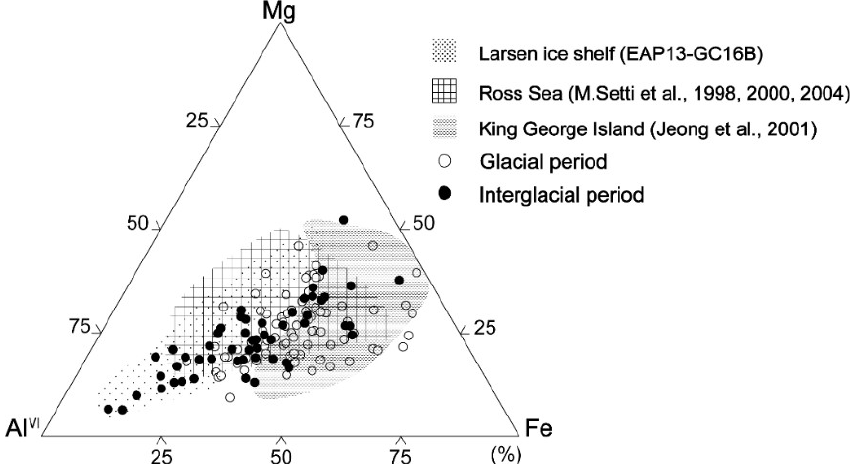
Figure 5. Ternary Al–Fe–Mg plot of the octahedral site composition of smectites for the glacial (white circle, MIS 2, 4, and 10) and the interglacial (black circle, MIS 9 and 11) sediments from core GC05- DP02. The compositional fields for smectites in sediments from near the Larsen Ice Shelf (core EAP13- GC16B), Ross Sea shelf (Setti et al., 1998, 2000, 2004 [30–32]), and King George Island (Jeong & Yoon, 2001 [33]) are also shown.